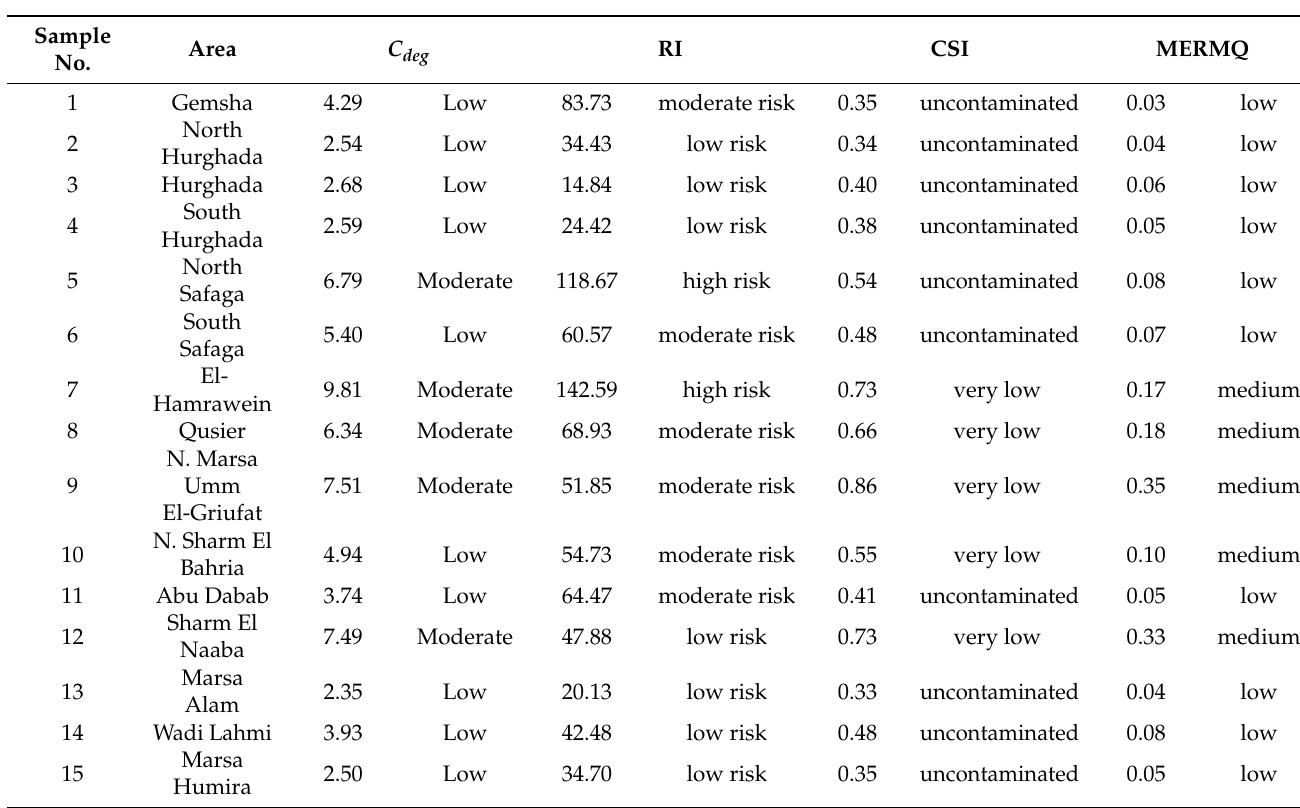
Table 6. C deg , RI, CSI, and MERMQ